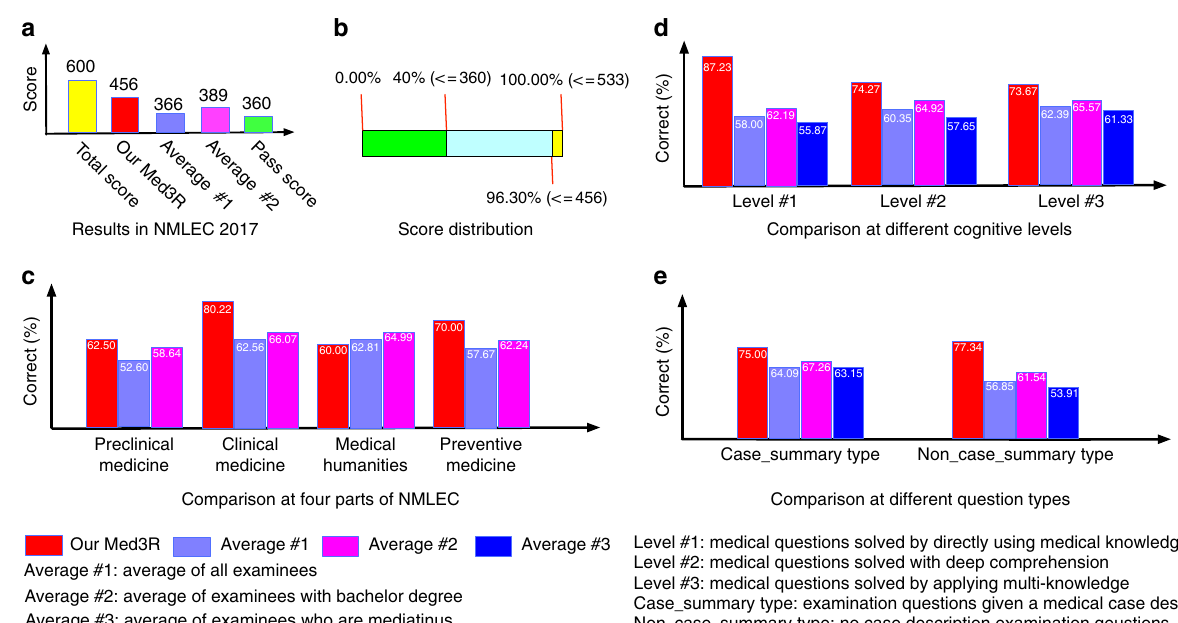
Fig. 2 The results of Med3R system participating in the written test of NMLEC 2017. Our Med3R achieved a 456 scores much higher than the passing- requirement of 360 scores, and b surpassed 96.3% human examinees. The questions of NMLEC 2017 are categorized by medical experts into different subgroups to further analyze our system ’ s performance. For example, the comparison at c 4 different subjects, d three different cognitive levels, and e two different types of questions. All results and data in this fi gure are of fi cially offered by NMEC